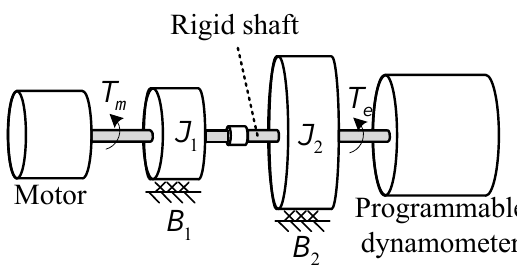
Figure 1. Emulation of mechanical loads using a